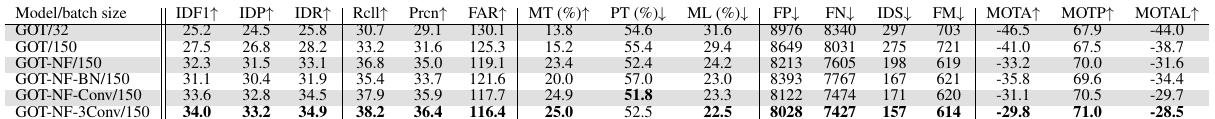
Table 2. Quantitative results of multi object tracking ablation study for the Vehicle dataset with the total number of 230 vehicles. The sequences are of 4.5 Hz. ↑ and ↓ stand for “higher and lower is better” accordingly. Model/batch size